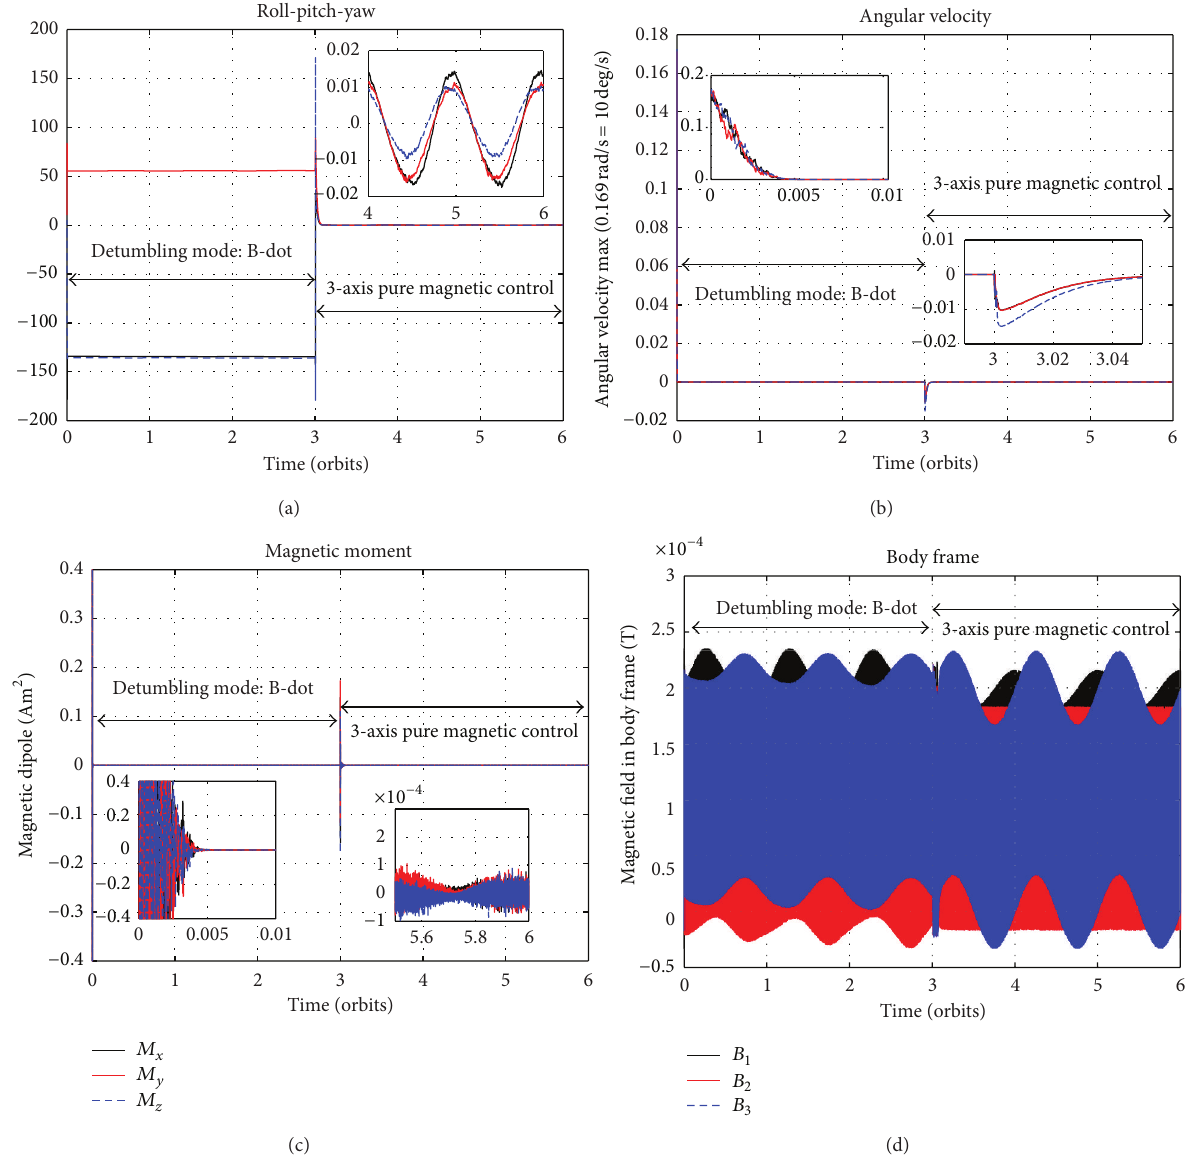
Figure 8: Scenario 2 detumbling mode and stable mode control